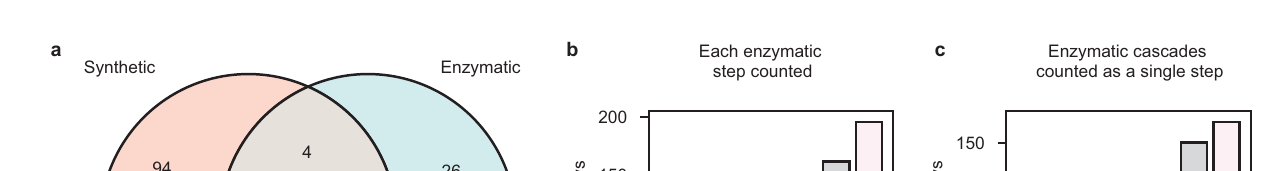
Fig. 5 | Example hybrid pathway search results for fl uoropyridinyl tryptoline. Pathways displayed from a pathway search using the enzymatic and synthetic template prioritizers (see Methods and SI for more details). Some reactions are